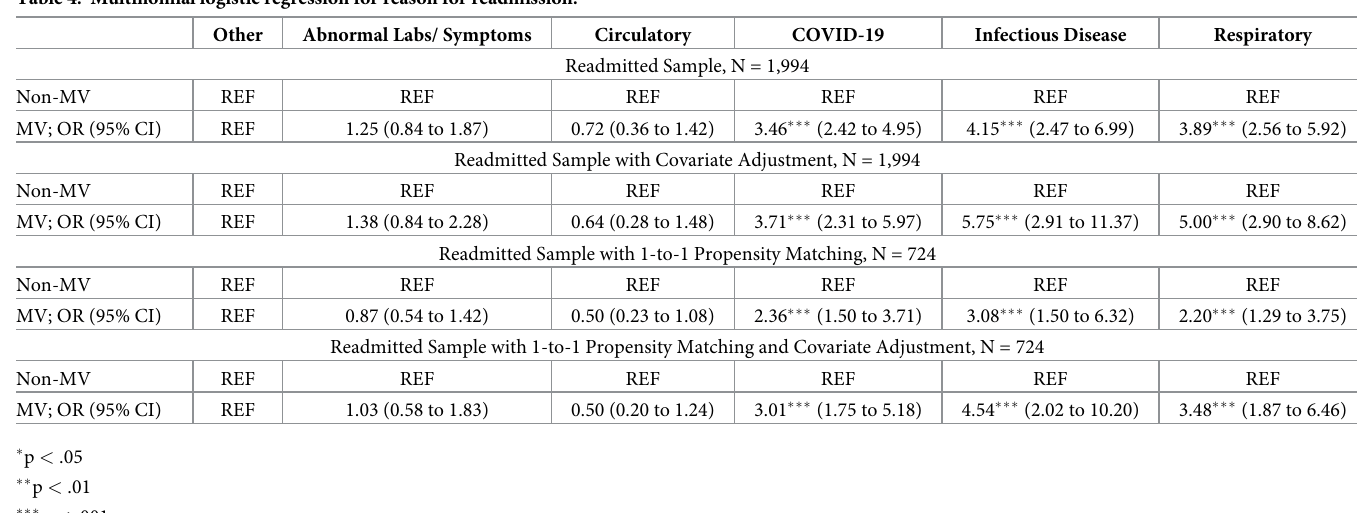
significant associations persisted across all four models. MV was not associated with increased